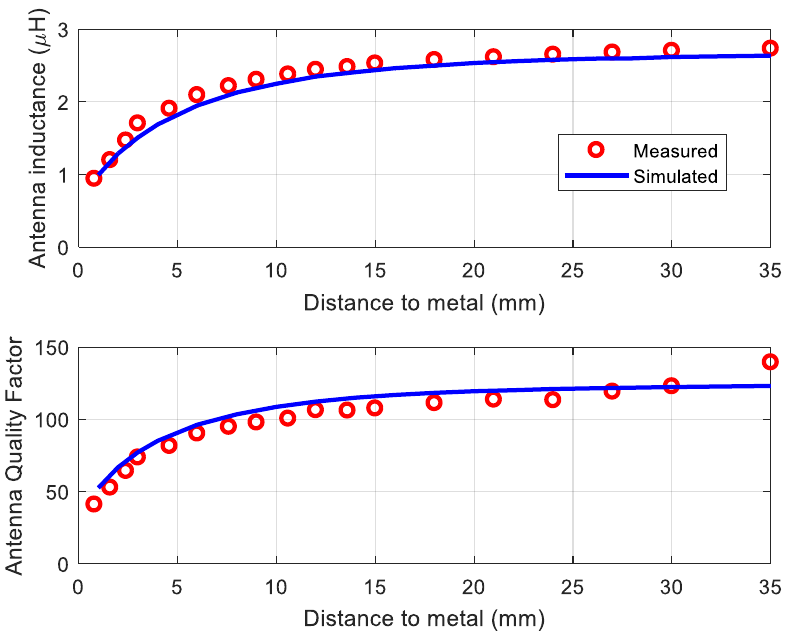
Figure 6. Simulated and measured antenna inductance ( top ) and quality factor ( bottom ) as a function of the distance to a ground plane [42].